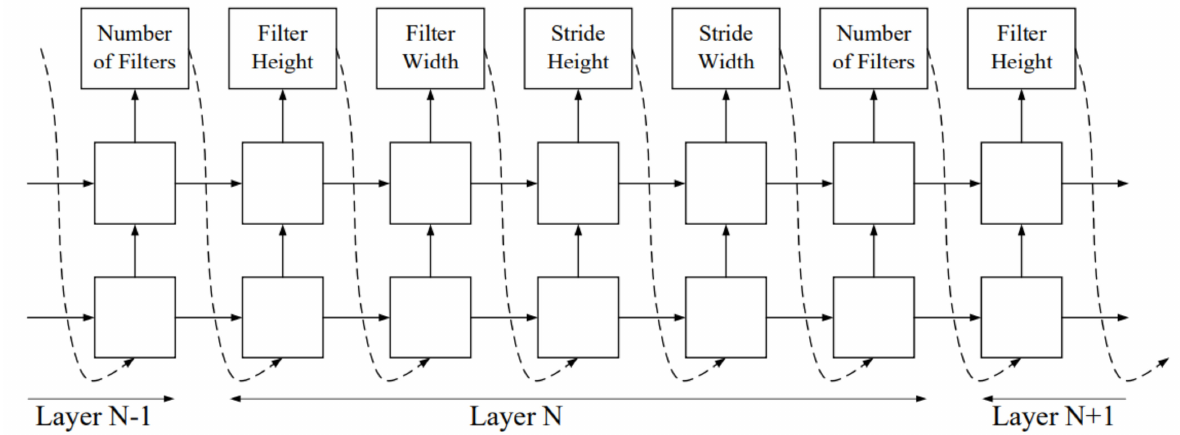
Figure 8. Predictive structure flowchart for RNN